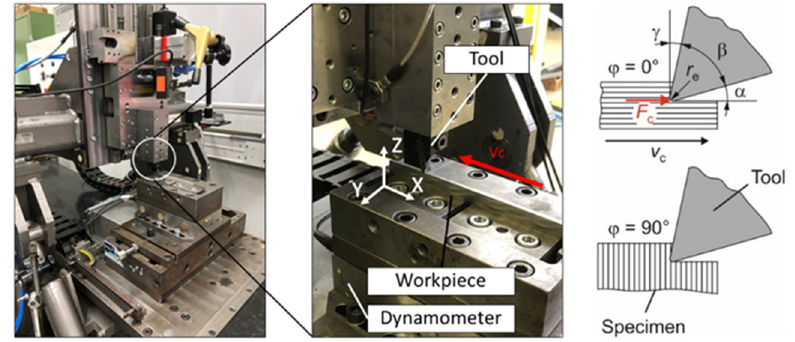
Figure 2. Test setup for experiments on orthogonal cutting and test conditions.